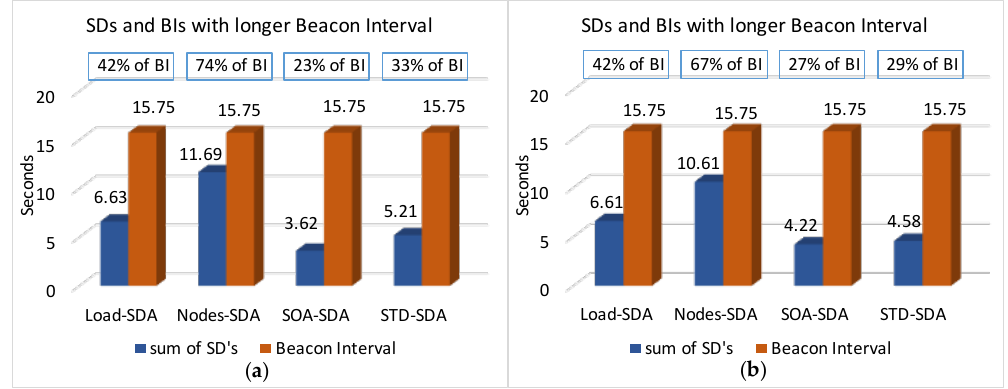
Figure 18. Beacon Interval and average sum of superframe durations for a network with a longer beacon interval in the: ( a ) Unconditioned Scenario; ( b ) Conditioned Scenario.